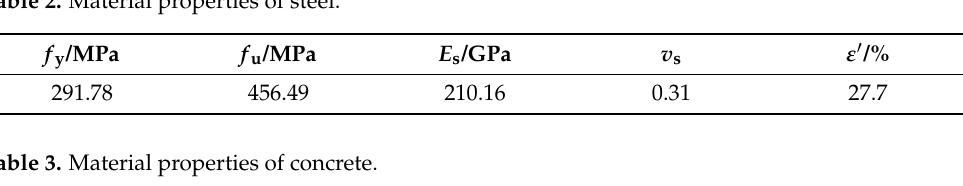
Table 2. Material properties of steel.